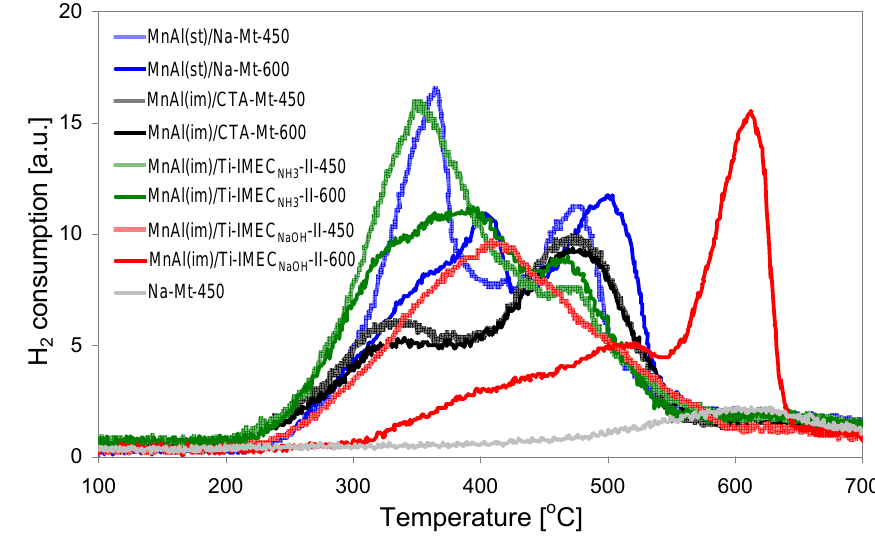
Figure 5. H 2 temperature programmed reduction (TPR) profiles of investigated composites calcined at 450 and 600 °C.